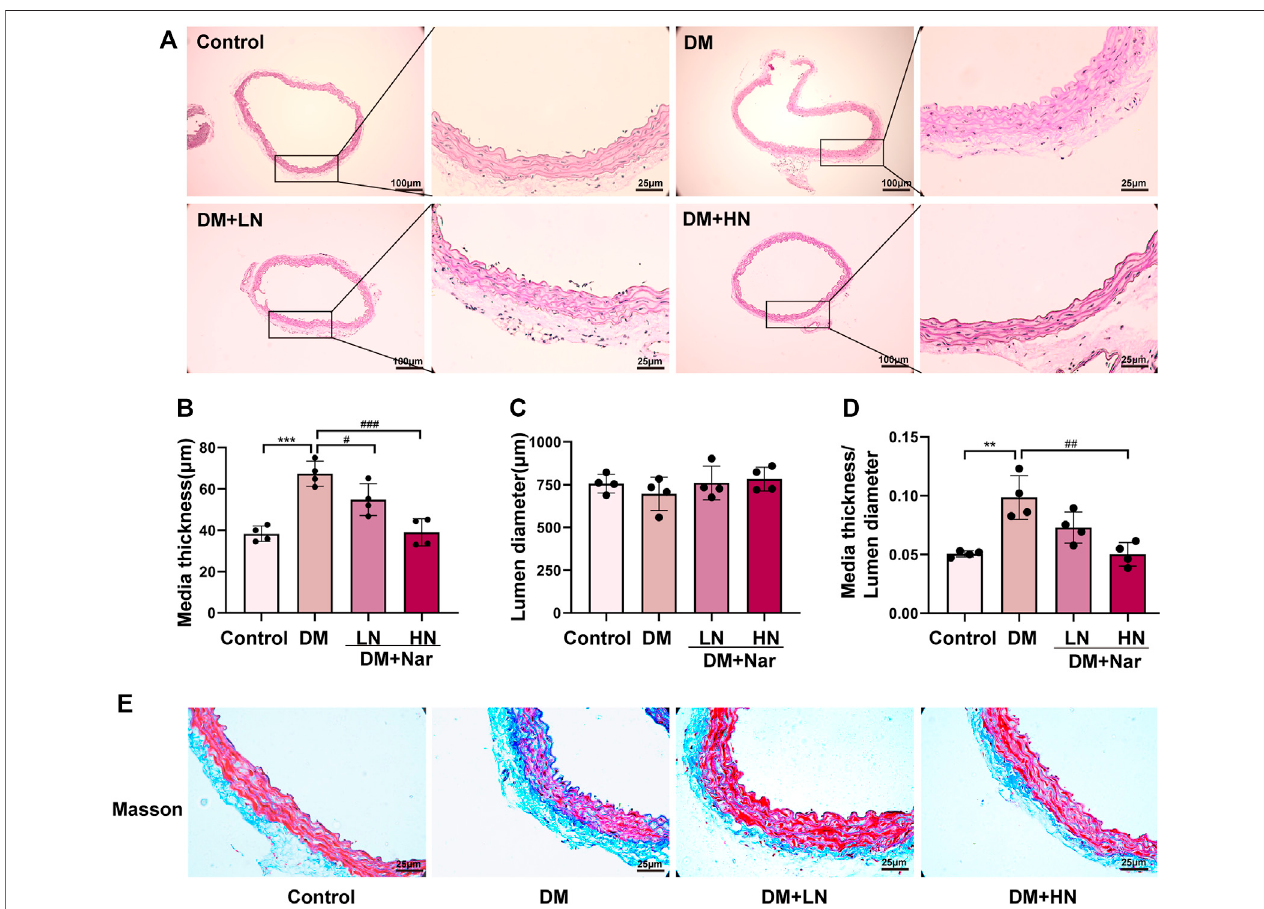
FIGURE 1 | Protective effect of Nar against diabetic angiopathies in vivo . (A) HE staining of thoracic aorta from diverse groups of mice. (B) Bar graph of media thickness of aorta in diverse groups. (C) Bar graph of lumen diameter ofaorta in diverse groups (D) Bar graph of HE staining analysis the ratio of media thickness/lumen diameter in aorta. ** p < 0.01, *** p < 0.001 compared with Control group, # p < 0.05, ## p < 0.01, ### p < 0.001, compared with HG group. (E) Representative images of Masson ’ s staining of the aorta (magni fi cation: